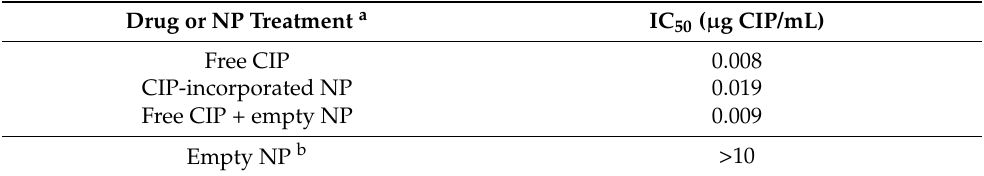
Table 2. IC 50 values of ciprofloxacin-incorporated nanoparticles against